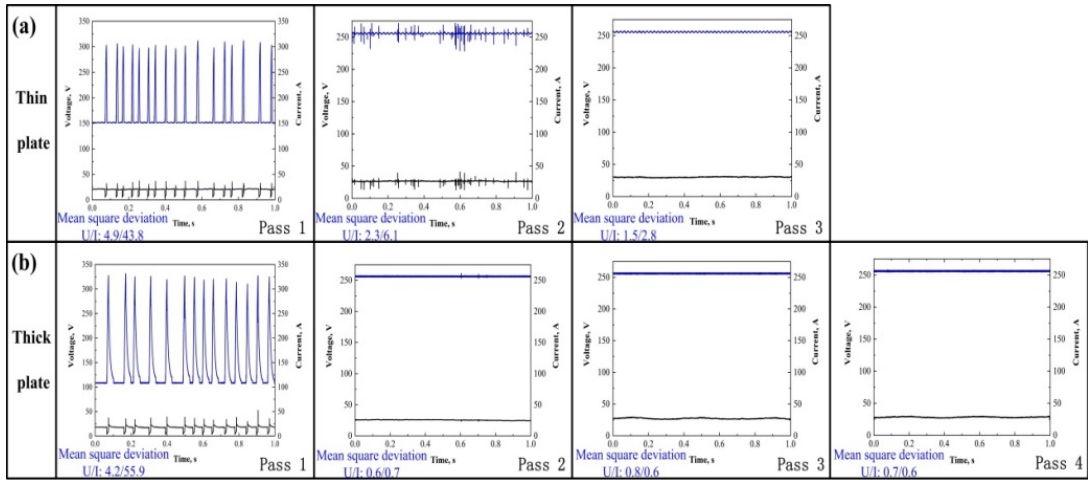
Figure 5. Electrical signal oscillograms for the ( a ) 1670-8 and ( b ) 1670-14. U / I represents the square deviation value of the thin and thick plates in 1 s.